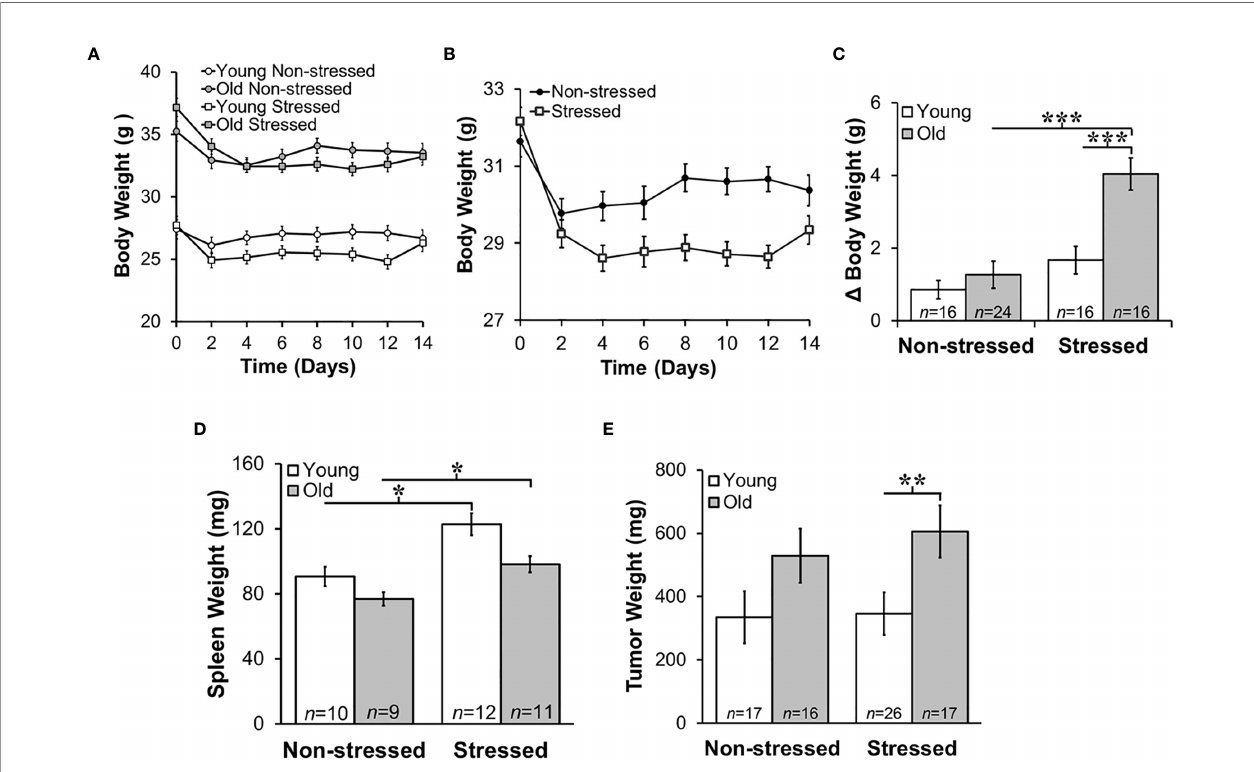
FIGURE 2 | Stress Most Affected Body and Tumor Weights in Old Mice and Increased Young and Old Spleen Weight. Mean body weights ± SEM in g ( n =16-25 per group) did not differ across time post-RM9 tumor inoculation between age-matched groups (A) or after collapsing data across age (B) . (C) However, there was a greater mean change ( D ) in body weight ( p <0.001) from baseline to study endpoint in old stressed mice compared with old non-stressed or young stressed mice. (D) Mean spleen weights (mg) were stress-dependently increased in young and old mice ( p <0.05). (E) Tumor weights (mg) were greater ( p <0.01) in old than in young stressed mice. * p < 0.05, ** p < 0.01, *** p <